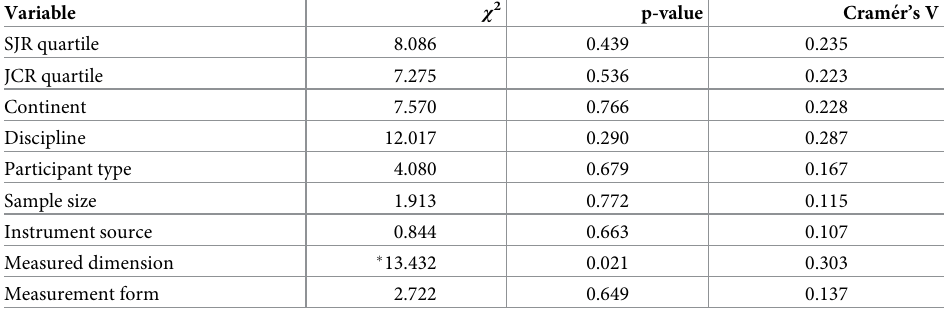
Table 7. Pearson’s Chi-squared tests of independence between Reporting Practice and demographic and methodo- logical variables.